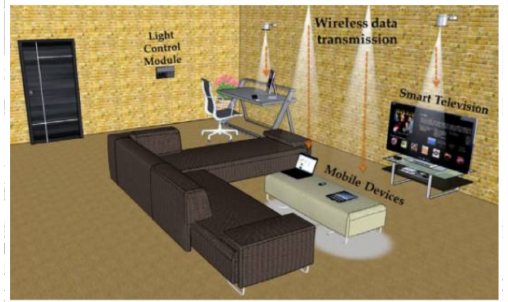
Figure 1. Example of a Li-Fi system. Reproduced with permission from [12], Elsevier, 2017. (Reprinted from Energy Build, 149, Chew, I. etc., Smart lighting: The way forward? Reviewing the past to shape the future. 180–191, Copyright (2017), with permission from